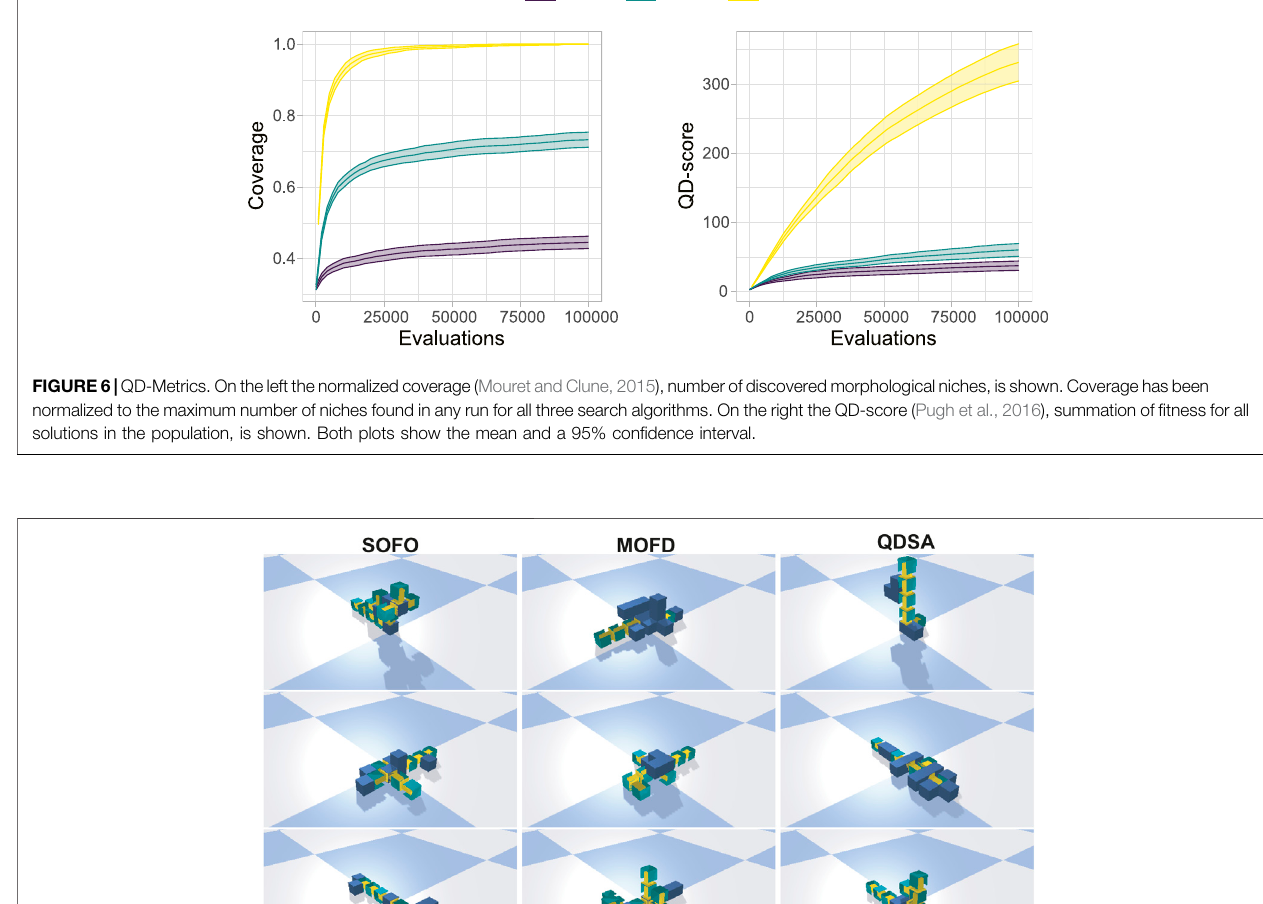
Frontiers in Robotics and AI |